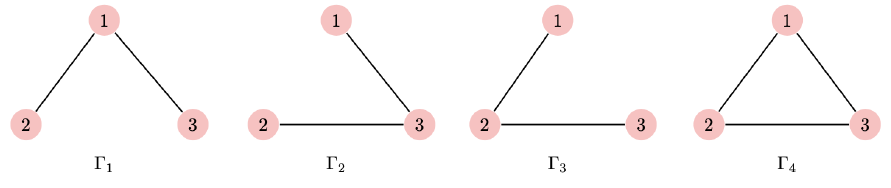
Figure 1. Network structures Γ 1 , Γ 2 , Γ 3 and Γ 4